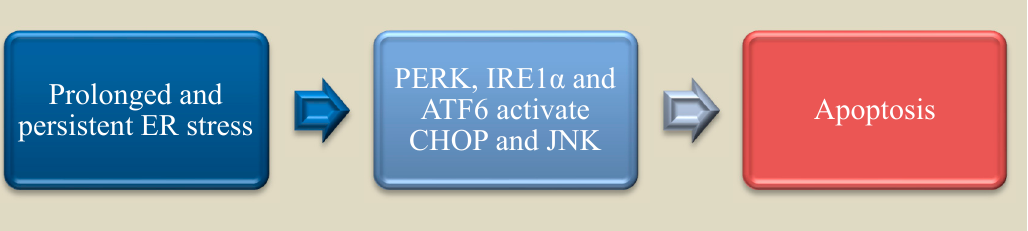
Figure 3. Schematic representation of pathways that lead the cell to progress from ER stress towards apoptosis.